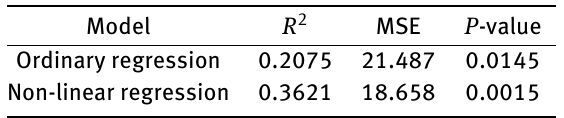
Table 1: Comparison results for ordinary with non-linear